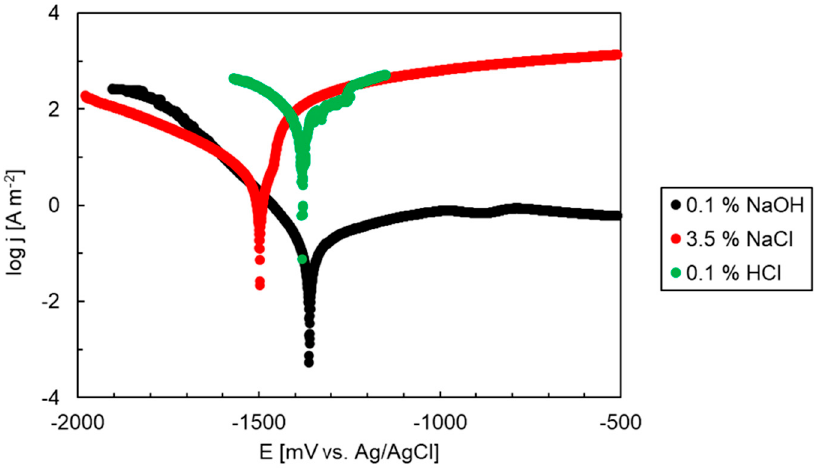
Figure 6. Polarization curves of the as-cast Mg 2 Sn alloy in different electrolytes. The experimental polarization curves were analyzed by Tafel extrapolation [39,44].